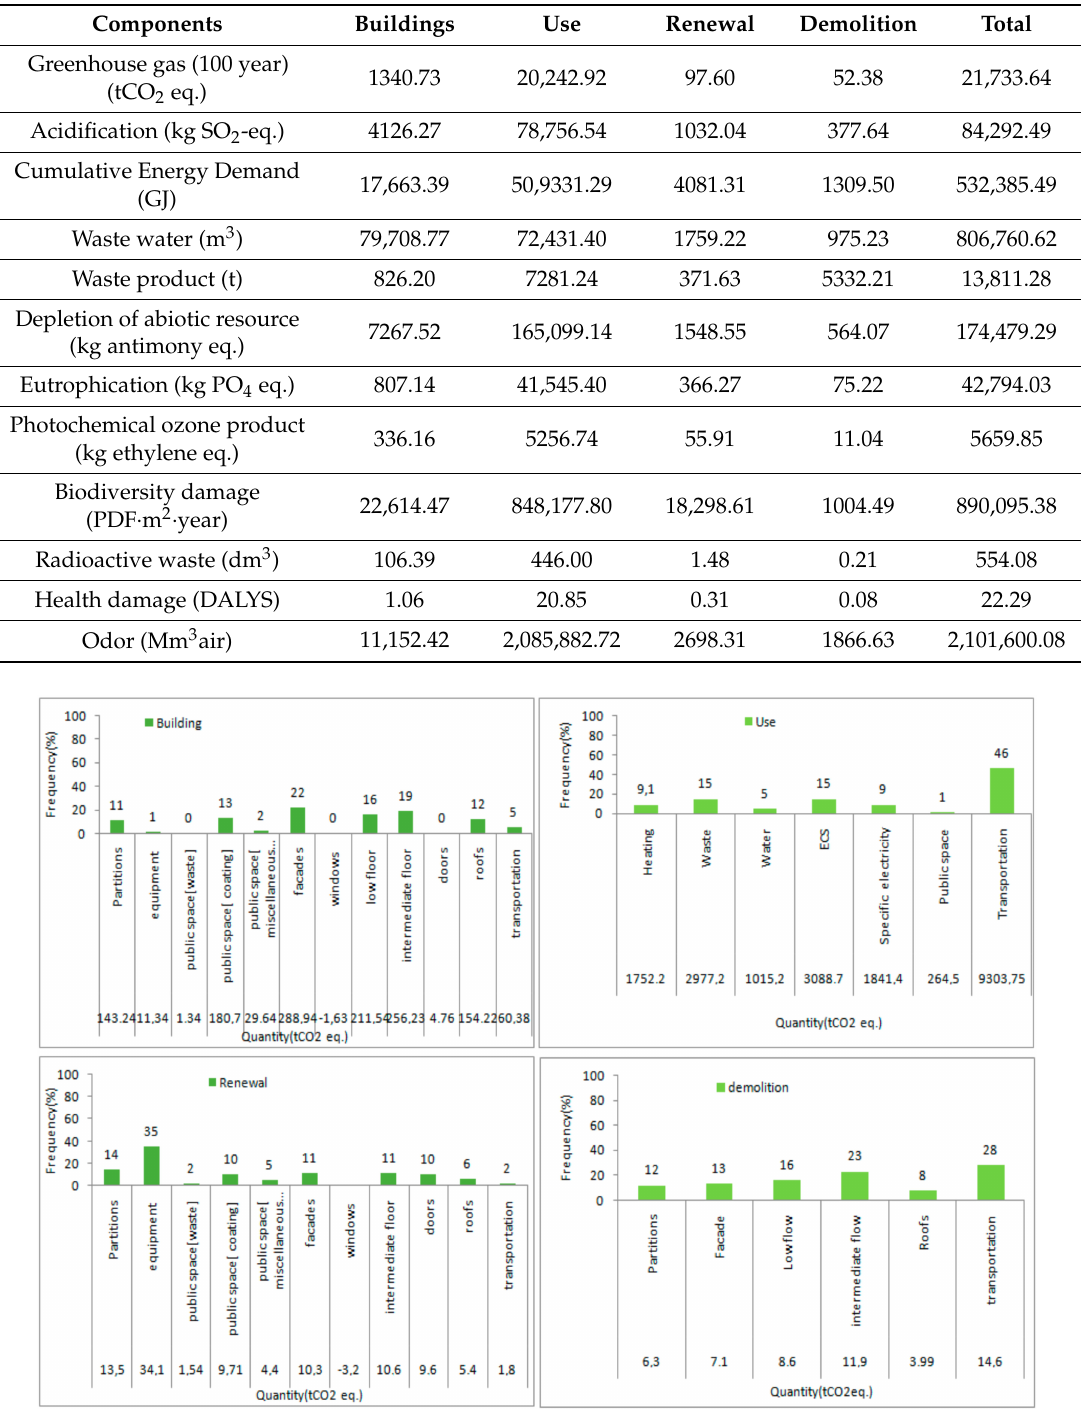
Table 5. LCA results at the neighborhood scale (initial case).